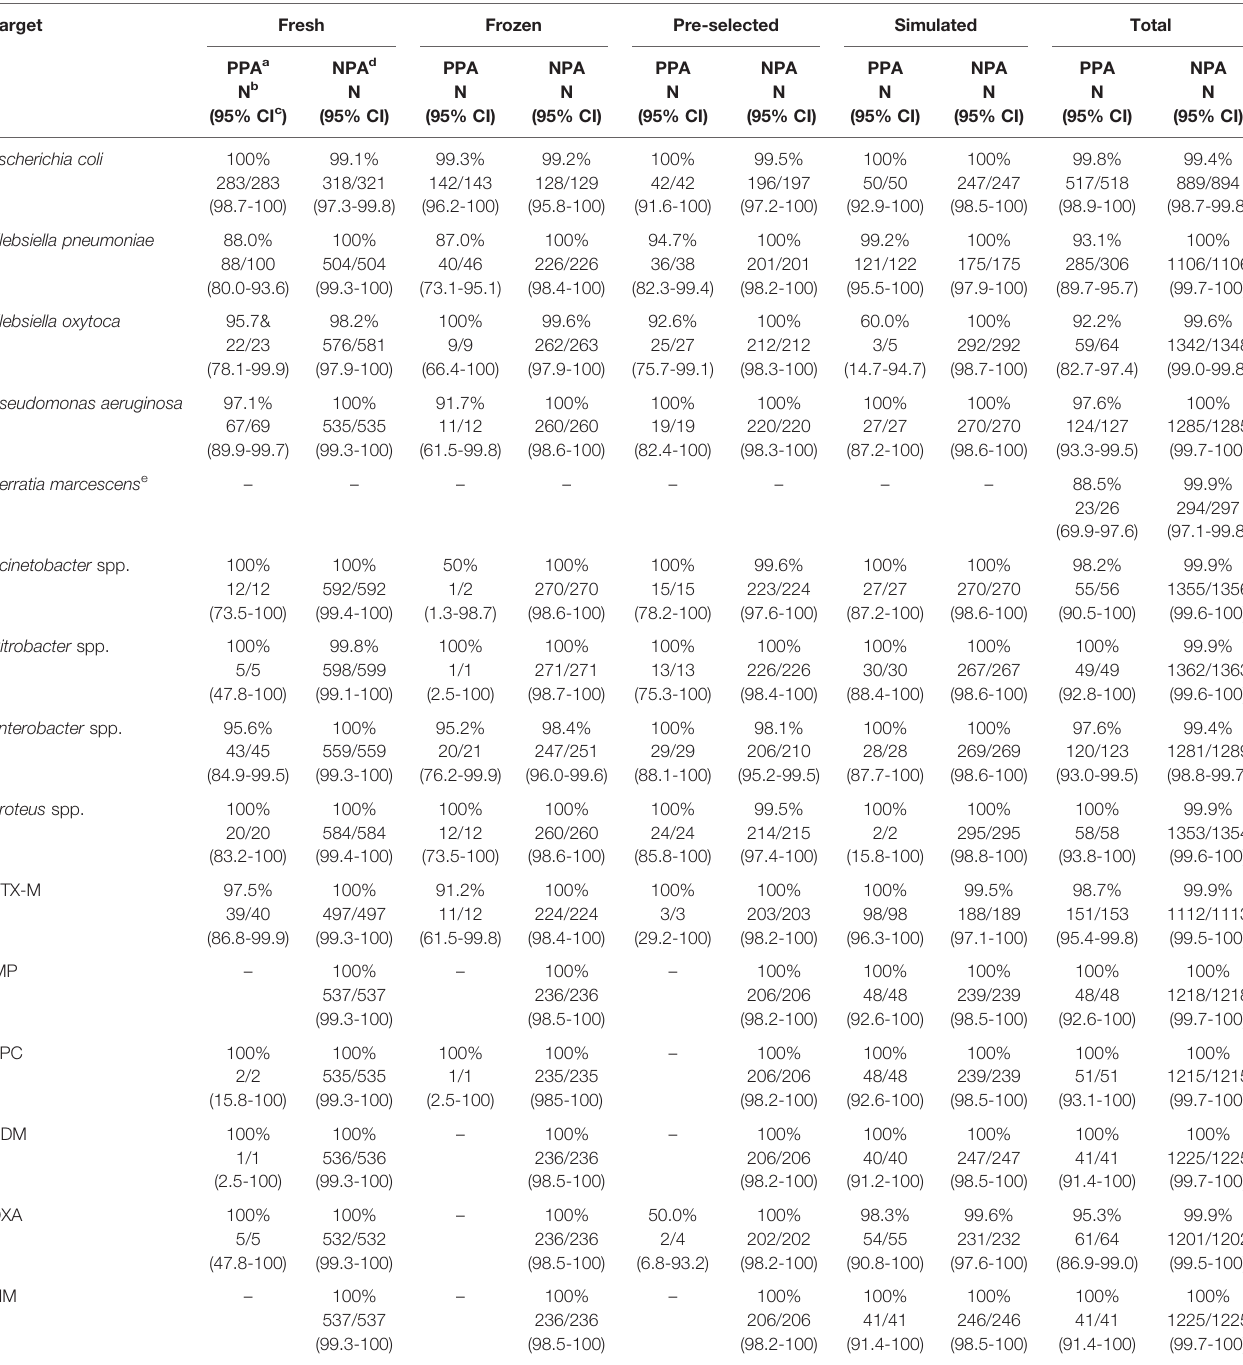
TABLE 4 | Summary of clinical performance for the VERIGENE Gram-Negative Blood Culture test.